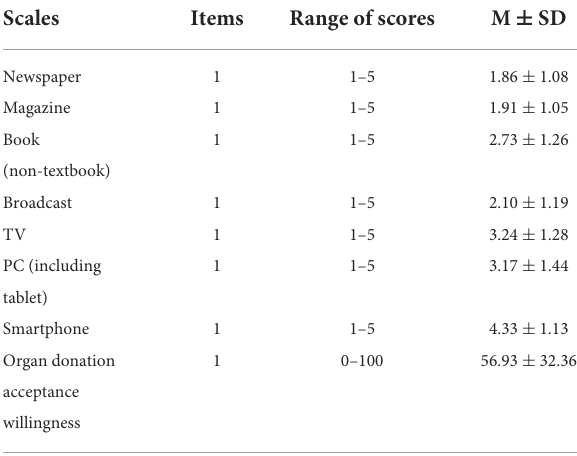
TABLE 3 The scores of media use and willingness to accept organ donation of the